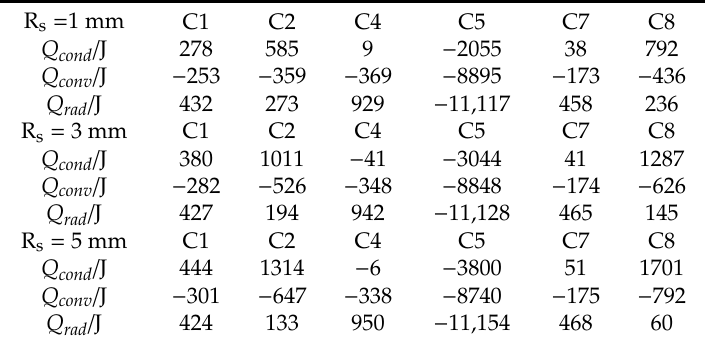
Table 3. Heat exchange quantities of each cell when R s = 1, 3 and 5